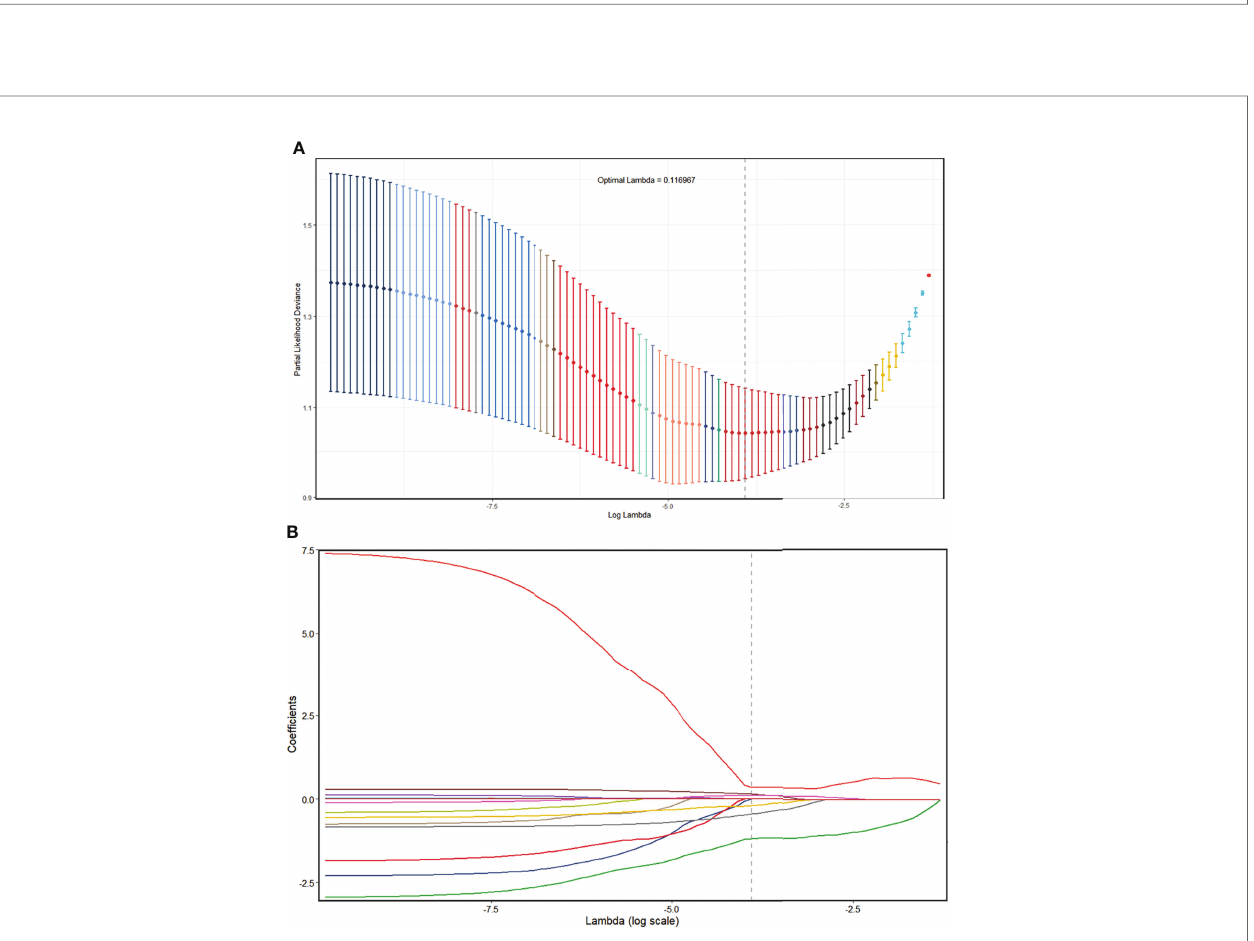
FIGURE 3 | ROC curves of the clinical (red lines), radscore (green lines), and combined (blue lines) models in the training set (A) and validation set (B) of the CECT model. The shaded areas represent the con fi dence intervals of the ROC curves. CECT, contrast-enhanced computed tomography; ROC, receiver operating characteristic.